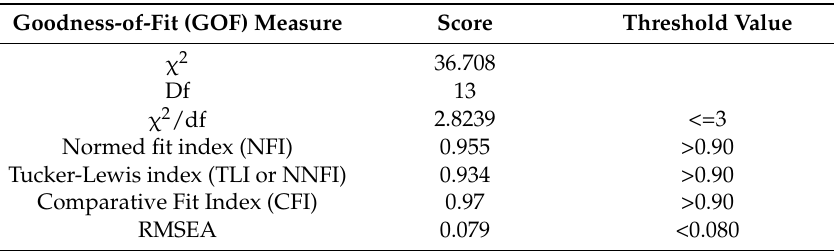
Table 3. Fit indices of structural model.